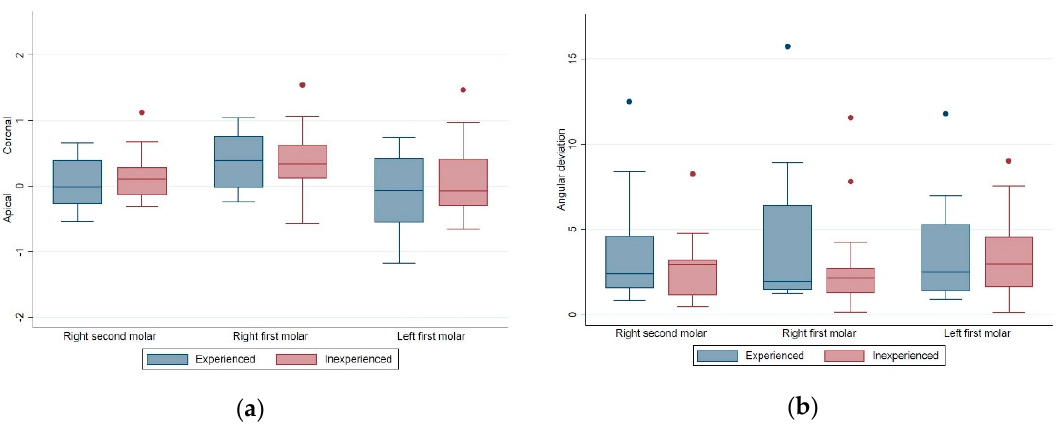
Figure 9. Box plots of the ( a ) depth deviation and ( b ) angular deviation of experienced and Figure9. Boxplotsofthe( a )depthdeviationand( b )angulardeviationofexperiencedandinexperienced inexperienced operator group. operator